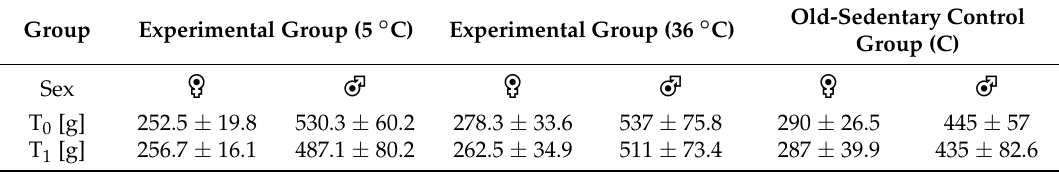
Table 1. Mean body weights of rats that participated in the study.